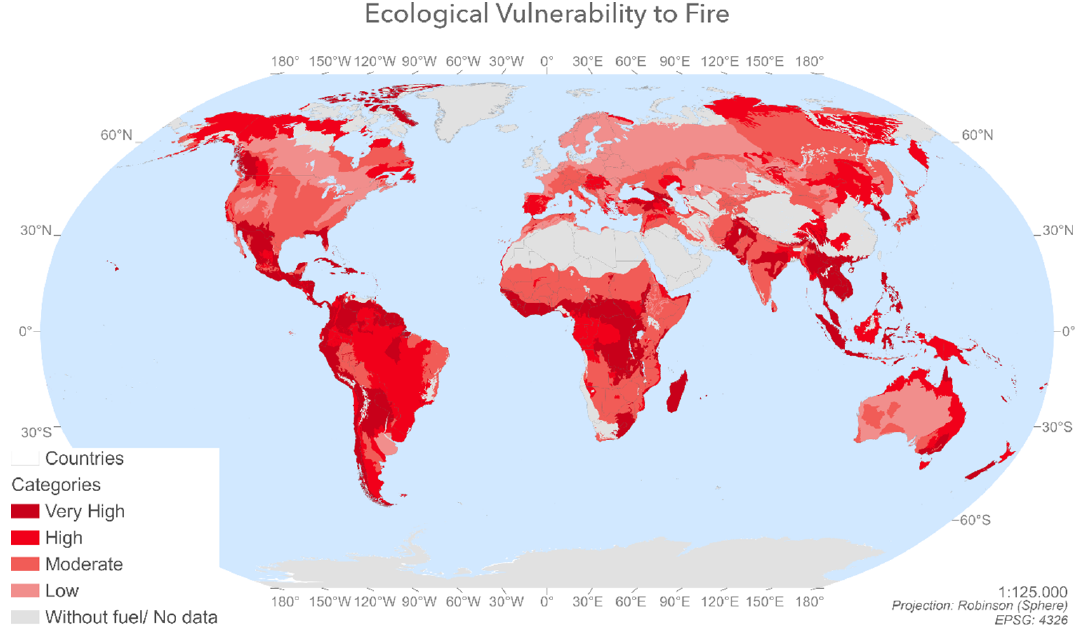
Figure 3. Spatial distribution of ecological vulnerability to fire index values calculated by combining the post-fire regeneration delay and the ecological indicator values by